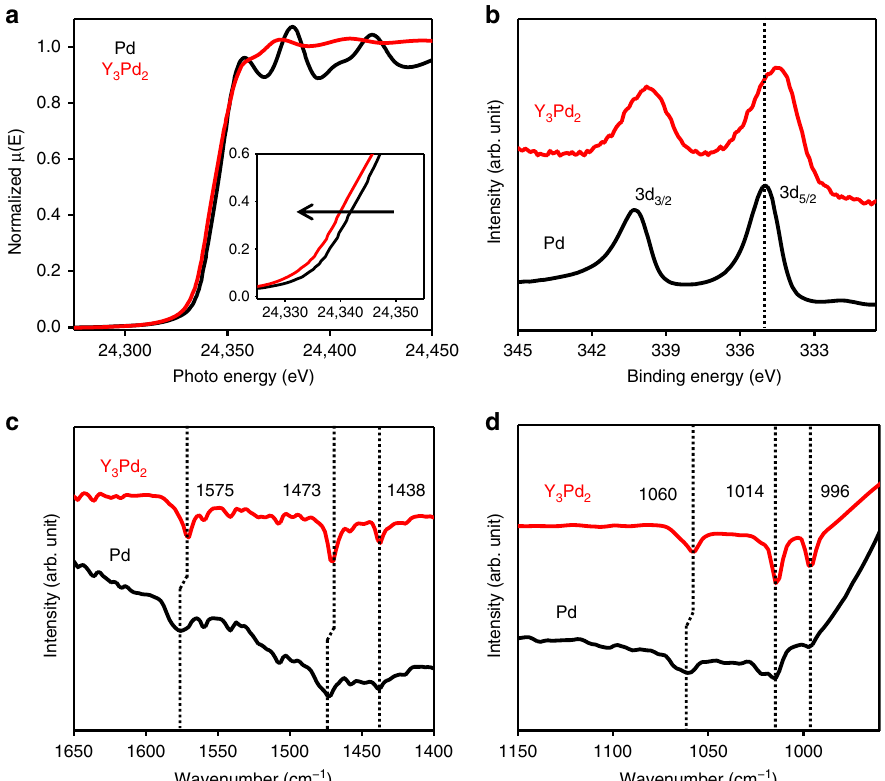
Fig. 3 Spectroscopy characterization of Y 3 Pd 2 and Pd. a Pd K-edge XANES spectra and b Pd 3 d XPS spectra for Pd and Y 3 Pd 2 . c , d DRIFTS spectra for the adsorption of iodobenzene onto Pd and Y 3 Pd 2 at 25 °C,